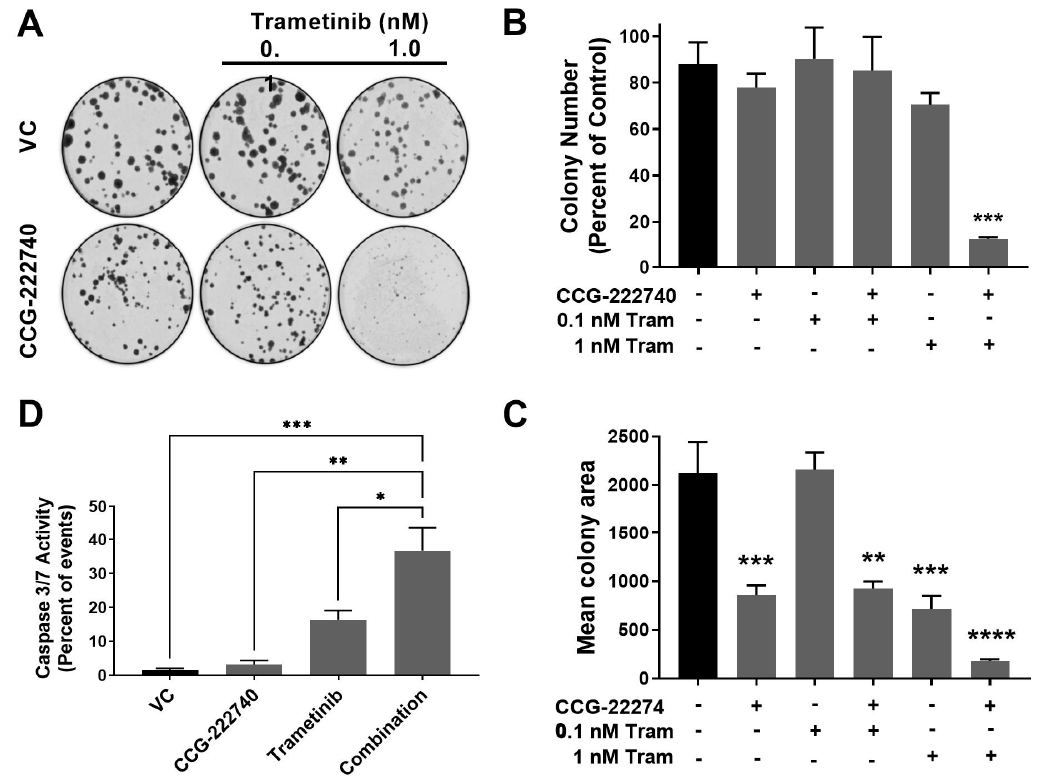
Figure 6. Combination treatment with trametinib and CCG-222740 inhibits clonogenicity and induces apoptosis in SK-Mel- 147 cells. ( A ). SK-Mel-147 cells were seeded at low density (200 cells/well) into 6-well plates and simultaneously treated with DMSO control, 6 µ M CCG-222740, 0.1 nM Trametinib, 1 nM Trametinib, or a combination of each. Representative clonogenic experiment is depicted. ( B ). Colony number was determined using ImageJ with a cutoff for colony size ≥ 50 pixels and circularity defined as 0.2–1.0. Results are expressed as the mean ( ± SEM) of triplicate experiments (n = 3, *** p < 0.005 vs. VC). ( C ). Mean colony area was determined using ImageJ, and the results are expressed as the mean ( ± SEM) of triplicate experiments (n = 3, ** p < 0.01, *** p < 0.005, **** p < 0.0001 vs. VC). ( D ). Caspase 3/7 activity was determined using flow cytometry 48 h after treatment with 10 µ M CCG-222740 and 12.5 nM Trametinib alone or in combination and 0.2% DMSO VC. The combination showed a significant increase in caspase activation compared to all other conditions. At that low concentration of trametinib, the increase was not statistically significant. Results are expressed as the mean ( ± SEM) of triplicate experiments (n = 3, * p < 0.05, ** p < 0.01, *** p < 0.005 vs. VC, one-way ANOVA with an all-against-all Tukey’s multiple comparison